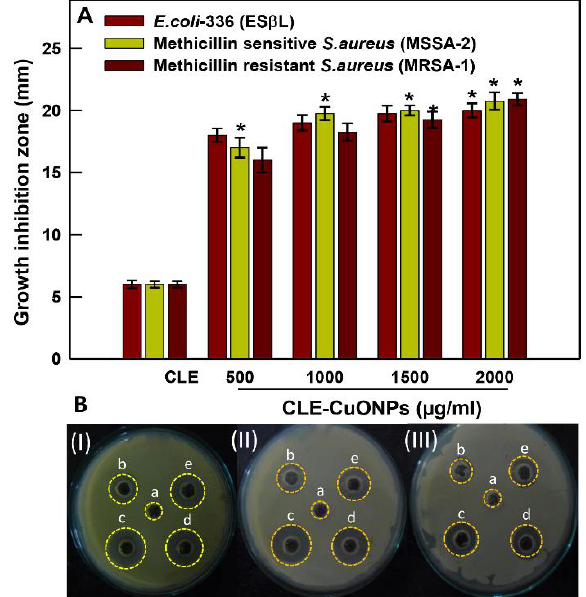
Figure 5. Antibacterial activity assessment. ( A ) shows assessment of antibacterial activity of CLE alone and CLE-CuONPs by a well diffusion assay. A volume of 100 μL CLE (10%) was taken as control. Each histogram represents the mean ± SD of two independent experiments done in triplicate; ( B ) representative culture plates of (i) Gram-negative ESβL producing E. coli- 336, (ii) Gram-positive methicillin-sensitive MSSA-2, and (iii) and methicillin-resistant MRSA-1 exhibiting zone of growth inhibition at (a) 10% CLE, and (b) 500, (c) 1000, (d) 1500 and, (e) 2000 μg/mL of CLE-CuONPs after 24 h of exposure.